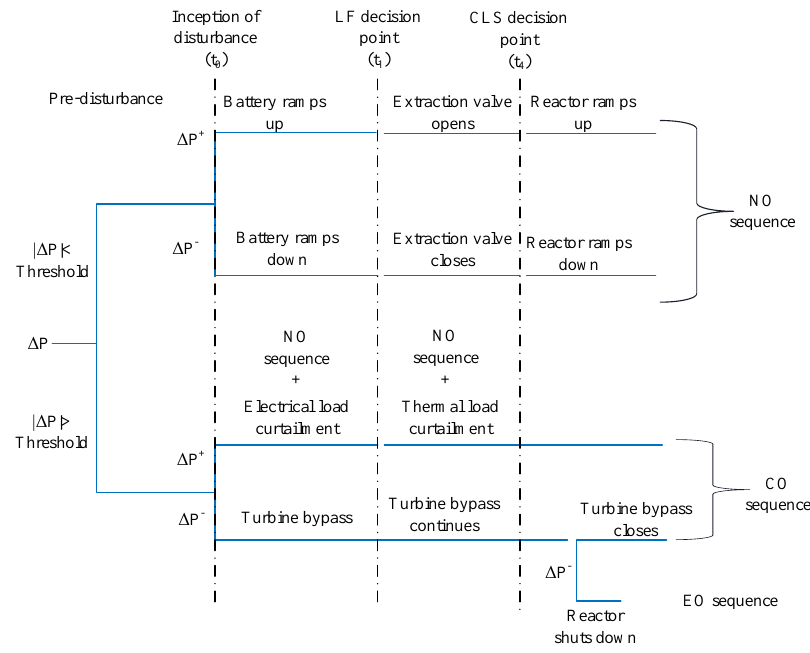
Figure 7. Event tree showing decisions with the inception of